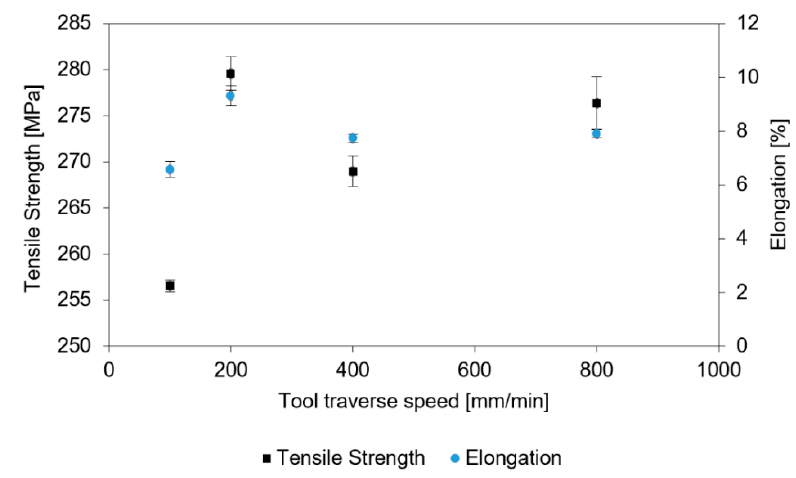
Figure 9. Established mechanical properties for joints obtained with the tool rotation speed of 800 rpm. Table 5. Established joint efficiency and fracture location of examined samples.